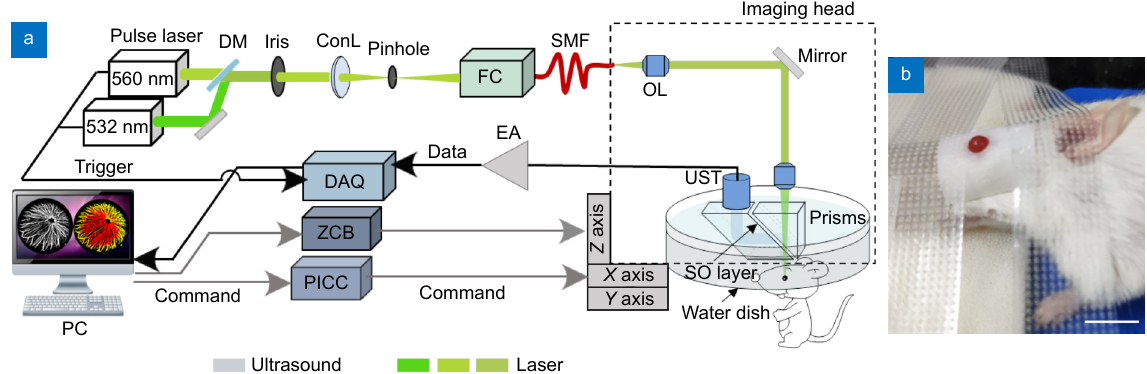
Fig. 1 | ( a ) The ophthalmic photoacoustic microscopy developed in this study. DM, dichroic mirror; ConL, condenser lens; FC, fiber coupler; SMF, single-mode fiber; OL, objective lens; UST, ultrasonic transducer; SO, silicone oil; EA, electrical amplifier; DAQ, Adata acquisition; ZCB, Zolix control box; PICC, Physik Instrumente control card; PC, personal computer. ( b ) The physical map of a mouse during imaging; Scale bar=10